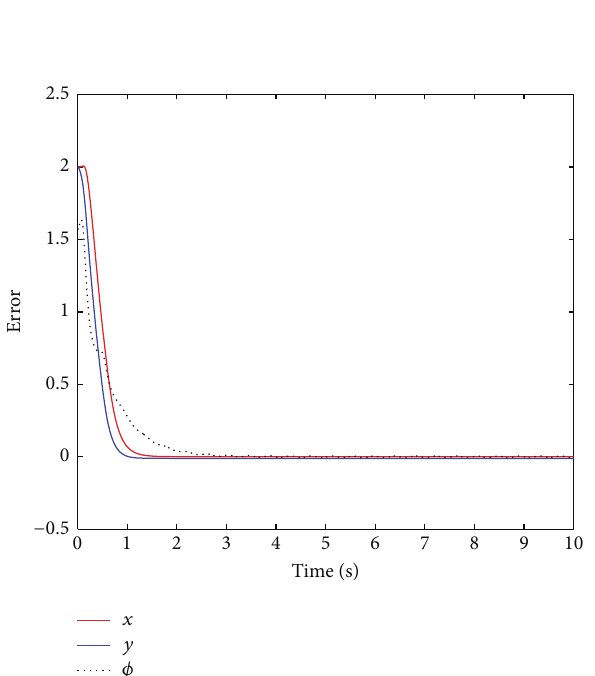
Figure 4: Control signals.